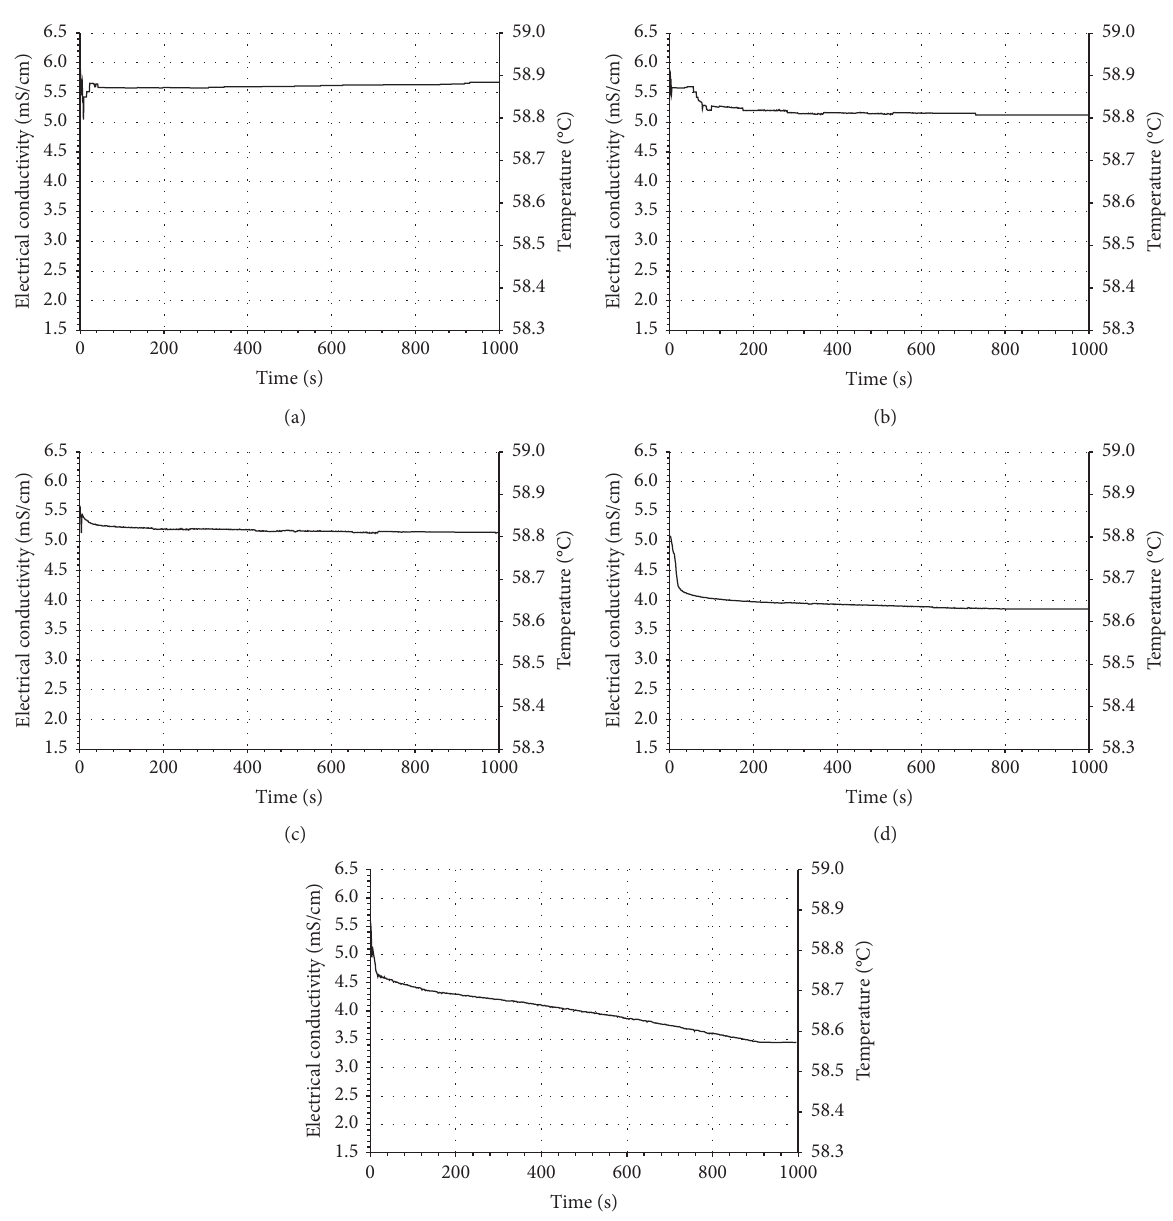
Figure 8: Electrical conductivity of (a) SCBA-A ash, (b) SCBA-B ash, (c) fly ash, (d) metakaolin, and (e) active silica.